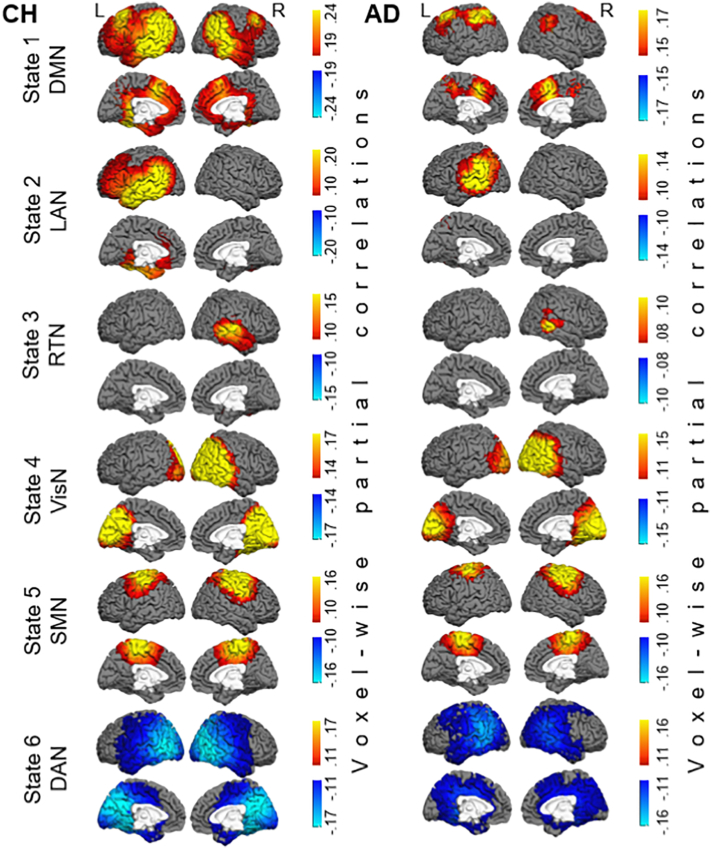
Maps of six salient states, which were inferred in the HMMs applied separately to the CH and AD group datasets. Maps of state-specific increases (in yellow/red/brown colors) and decreases (in blue color) in oscillatory amplitudes in the CH group are shown in the left panel and in the AD group in the right panel. Each map shows partial correlations between the state time-course and the oscillatory (4–30 Hz) amplitude envelopes in individual brain voxels. Abbreviations are the same as in Fig. 2.